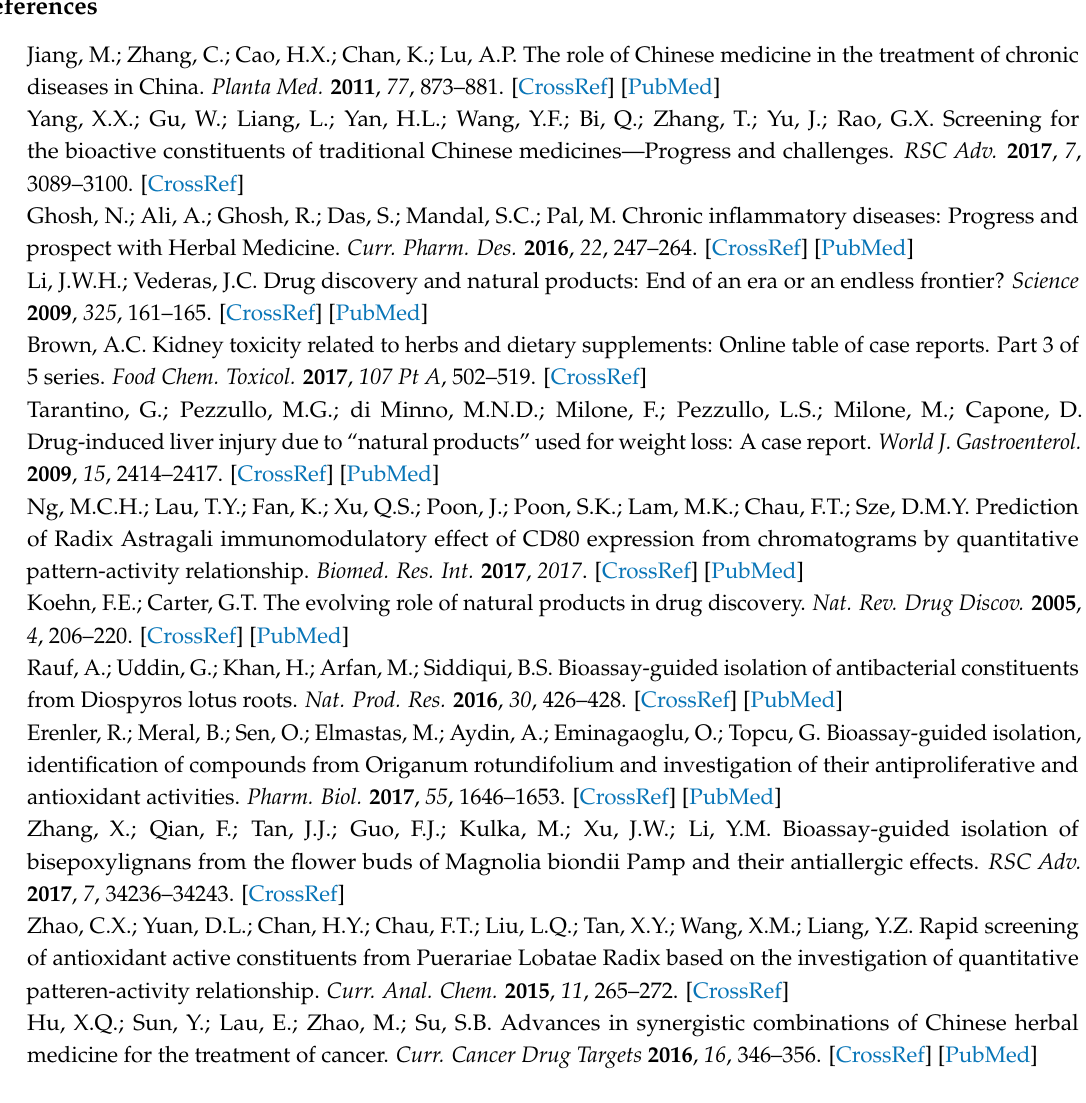
Supplementary Materials: The following are available online. Figure S1: CV of compounds’ area in all Herba epimedii samples in total ions chromatogram (TIC, A) and liquid chromatogram (B). Figure S2: Overlapped UV spectrum of 73 compounds extracted from liquid chromatogram. Figure S3: Principle component analysis (PCA) score plot of UV spectrum of 73 features, Table S1: Final concentrations of 6 standards in mixtures 1–8, Table S2: Information of Herba epimedii leaf samples purchased in